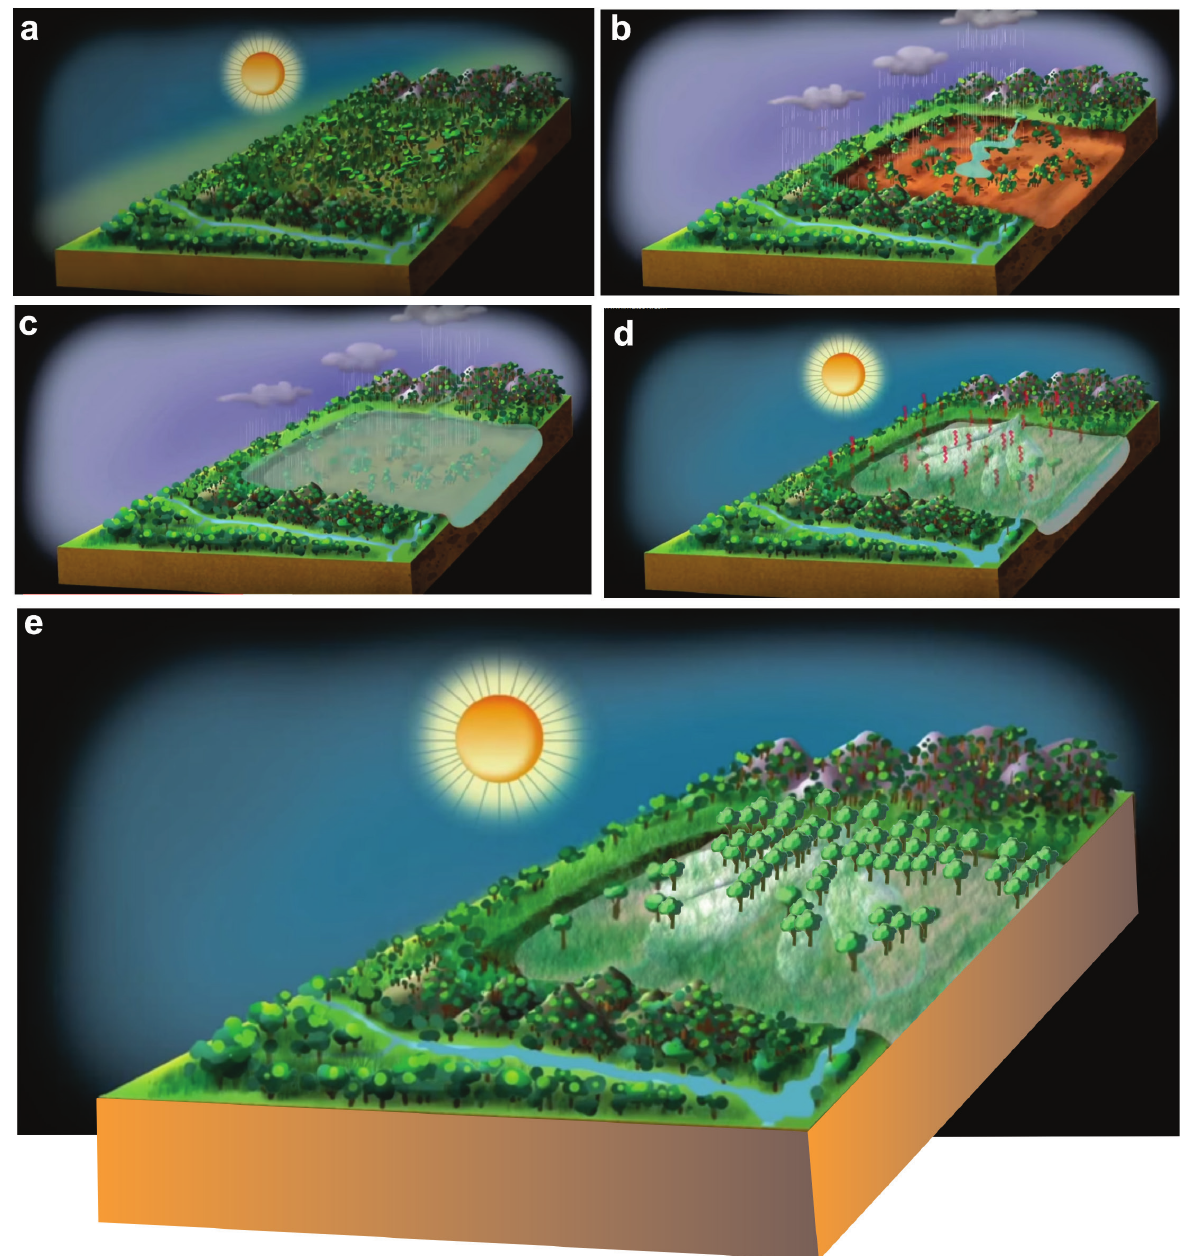
Figure 7 - Schematic model that illustrates how the sedimentary dynamics related to the Amazonian megafans may have proceeded to create suitable terrains for the development of the patches of white sand vegetation in a rainforest matrix. a) Amazonian region covered by typical rainforest. b ) tectonically-triggered instability leading to mild subsidence. c ) the subsiding terrain was more suitable to flooding, creating wetlands during wet seasons. d ) The wetlands were filled with sediments sourced from the erosion of the highland rocks of the Guyana Shield, forming the sandy-dominated megafans. e ) After abandonment only a few thousand years ago, the nutrient-poor sandy megafan deposits constituted favorable sites for colonization by white sand vegetation. Grasslands/ shrublands occupy topographically lower-lying terrains, most influenced by seasonal flooding, whereas physiologically adapted white sand trees colonize areas that remain topographically higher (see text for further